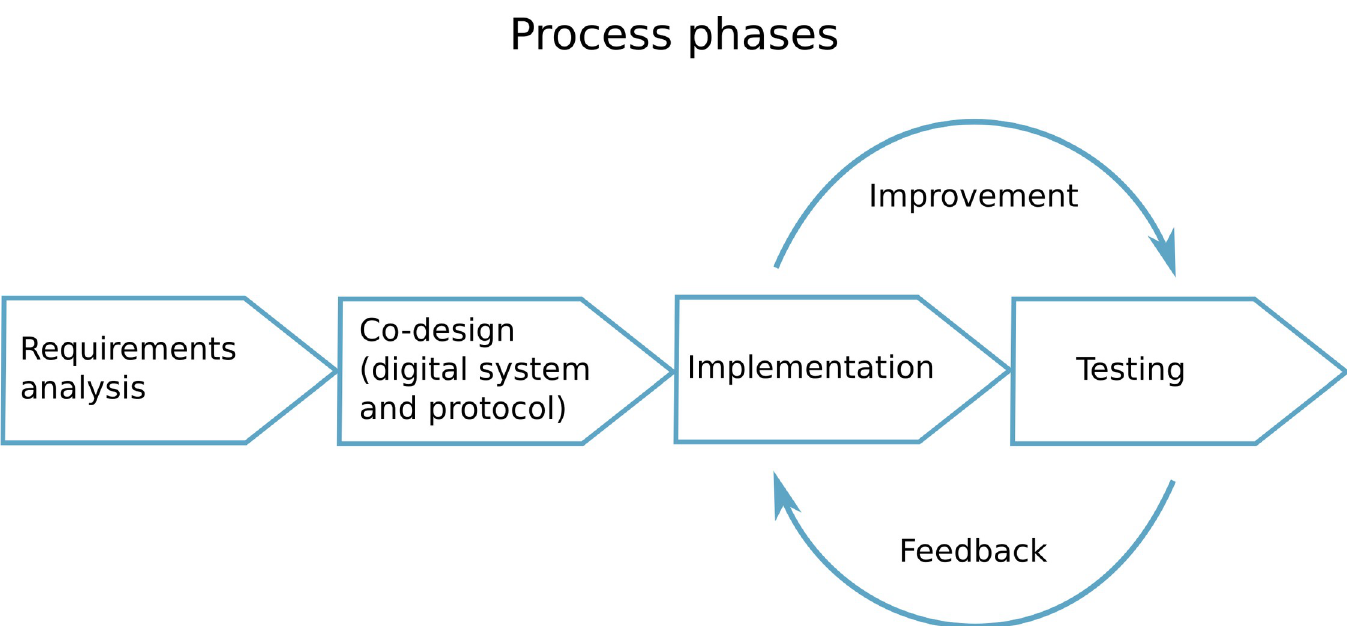
Fig 1. Process phases. a sequential approach was adopted. The first phase consisted in the requirements analysis followed by the co-design of the technological solution and definition of the operative protocol for teleophthalmology. The third phase comprised the implementation of the digital solution (TreC Oculistica system) and the fourth phase the testing of the system and protocol. A continuous exchange of feedback between the implementation and testing phases allowed to identify and implement possible